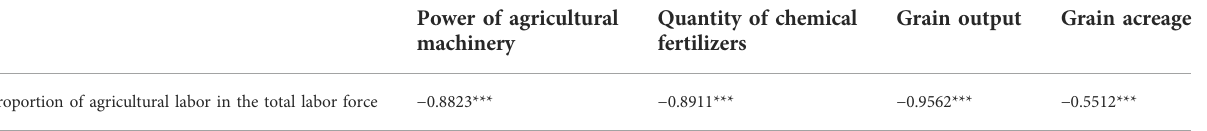
TABLE 1 Spearman correlation coef fi cient between ALT, chemical fertilizers and agricultural machinery and grain output.